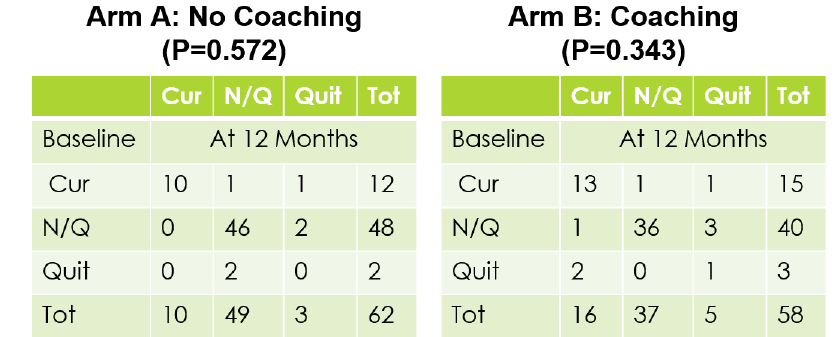
Figure 6. BMI by study visit and randomization group.